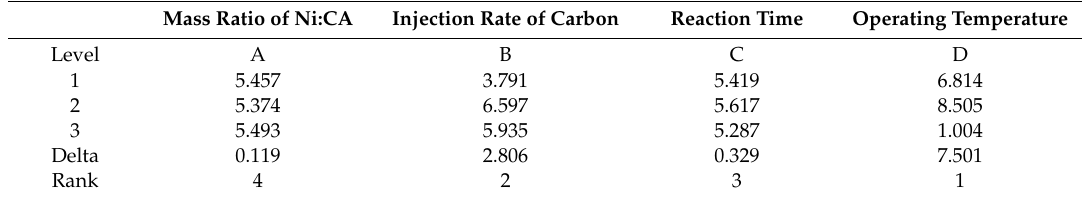
Table 2. Response table of S/N ratios at different factor levels.